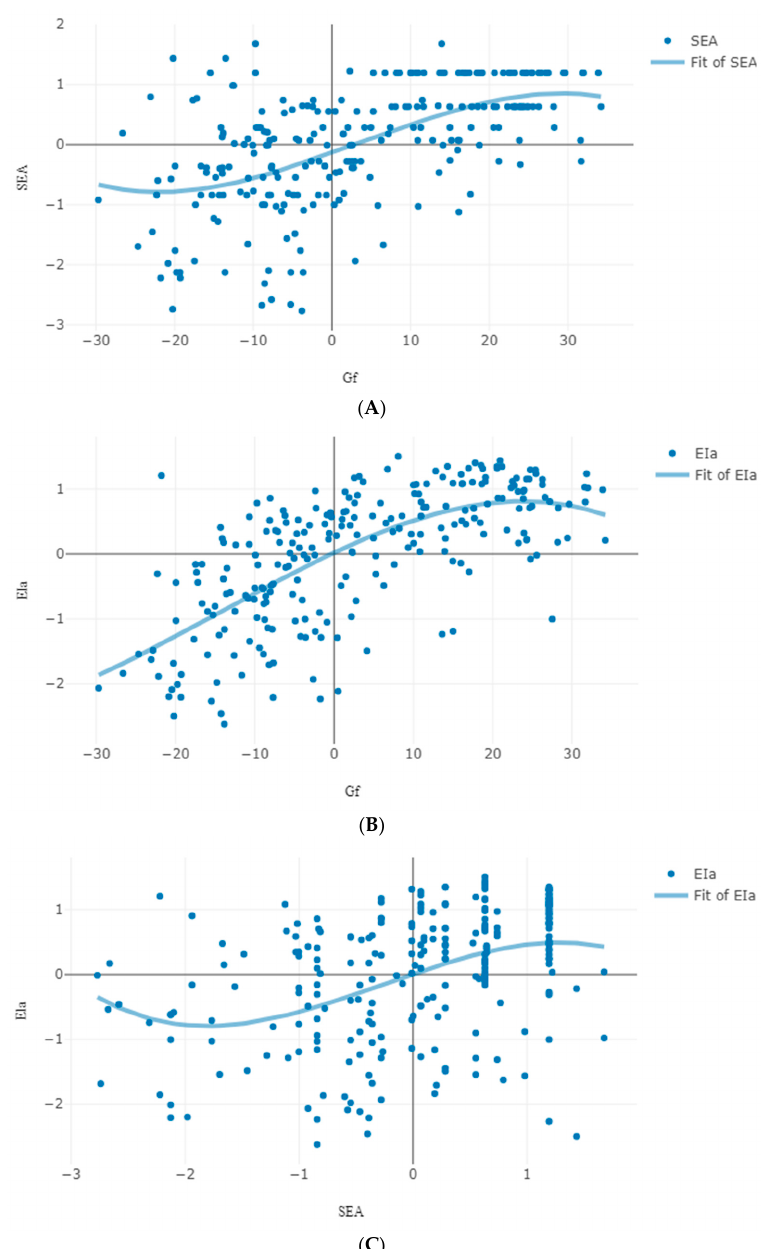
Figure 7. Relations between Gf and SEA (self-evaluation accuracy) (Panel A , R 2 = 0.38), Gf and EIa (ability to understand and define emotions) (Panel B , R 2 = 0.49); and SEA and EIa (Panel C , R 2 = 0.05). Relations between age and the various traits differed from above. Specifically, self- representations in cognizance (which is a second-order self-representation) decreased systematically with age. As a result, the main effect of age was non-significant, F (4, 242) = 0.65, p > 0.05; η 2 = 0.01,